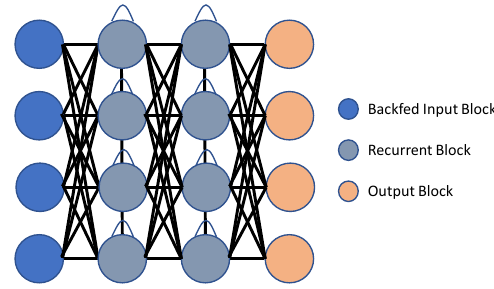
Figure 8. RNN block diagram.